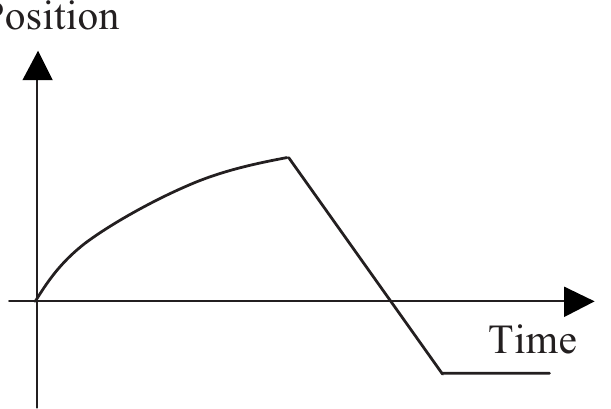
FIG. 3. Excerpt of a tutorial on acceleration.